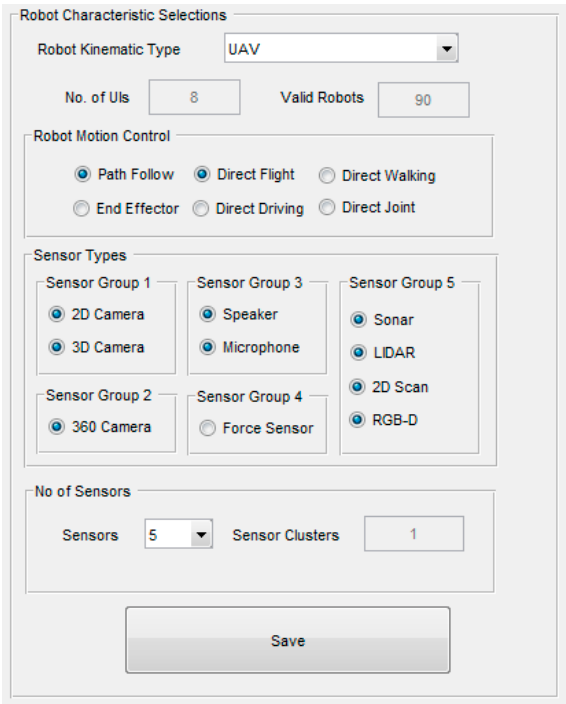
Figure 8. Matlab toolbox characteristic selections.